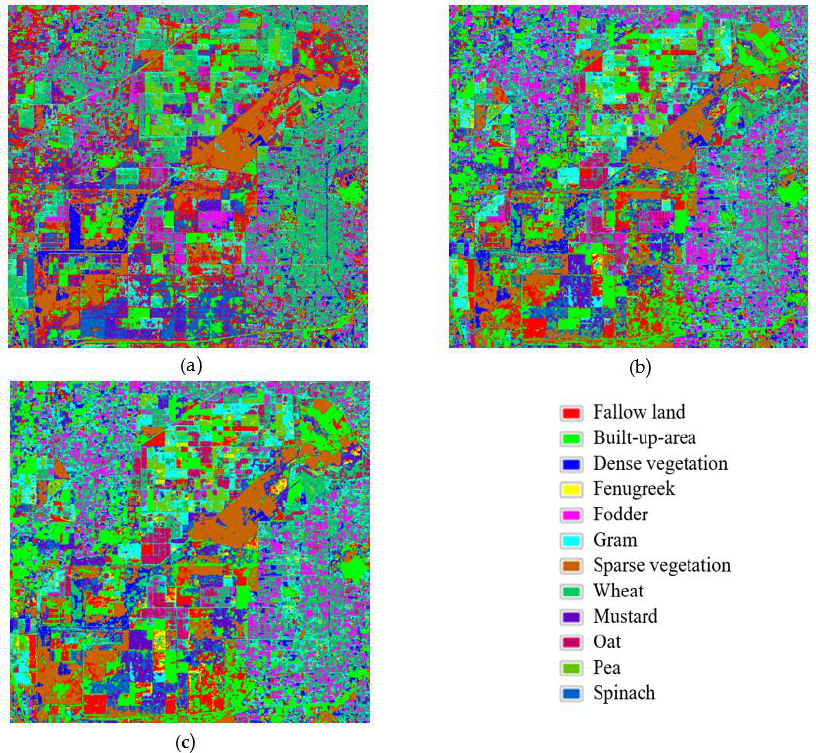
Figure 6. Classified images for VV polarization using ( a ) SGD, ( b ) SGB, and ( c ) XGB classifier with patch size = 3.